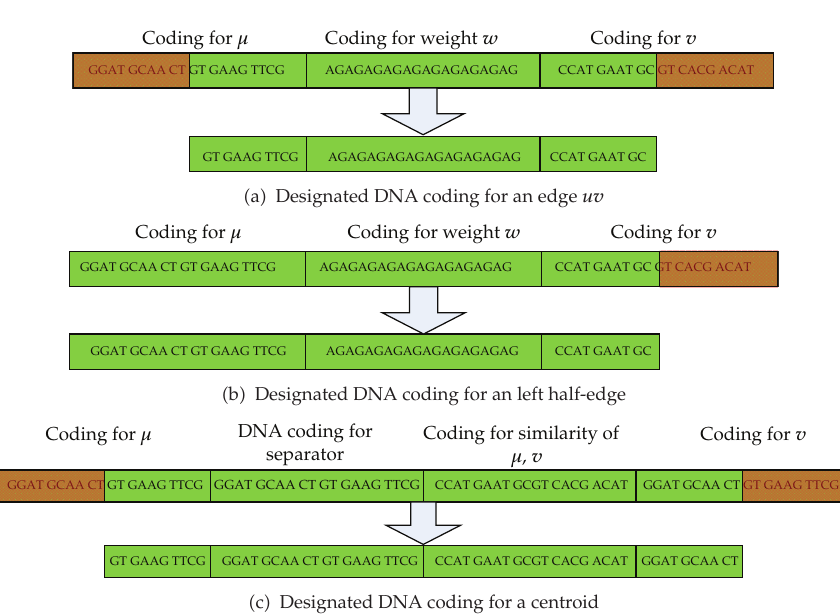
Figure 6: DNA-encoding